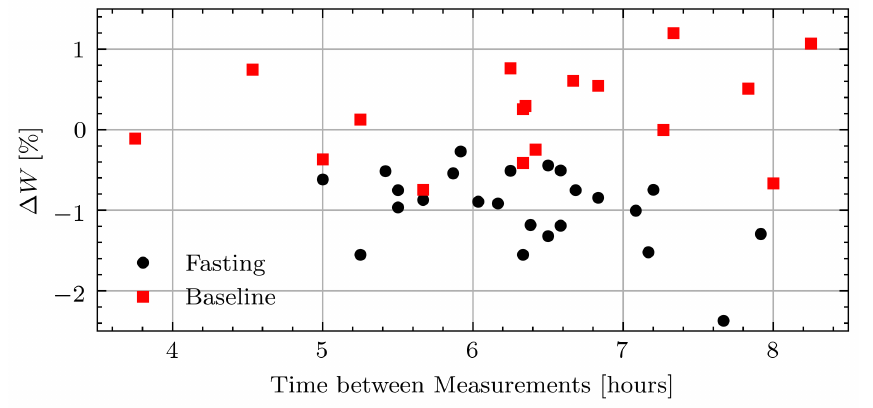
Figure 8. Relative weight change in pilot study volunteers while fasting and at